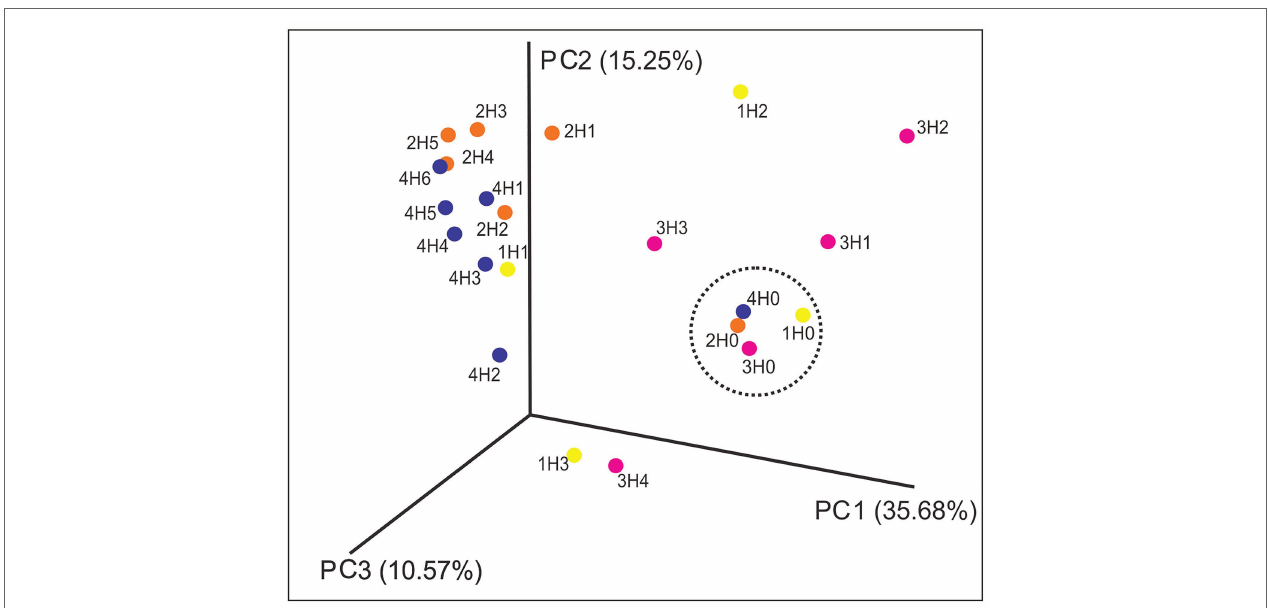
FIGURE 2 | Principal coordinate analysis (PCoA) plot based on weighted UniFrac distance metric of samples (PERMANOVA test, 999 permutations). The black circle shows the clustering of surface sediment samples (1H0, 2H0, 3H0, and